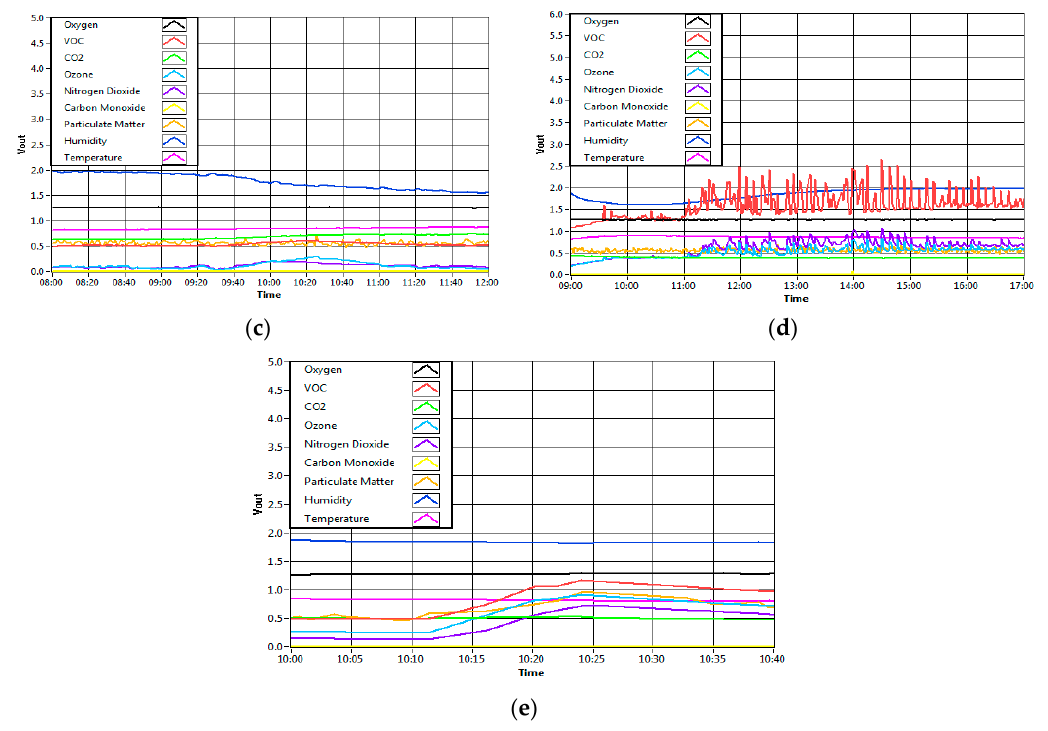
Figure 4. ( a ) Ambient environment; ( b ) Chemical presence; ( c ) Food and beverages; ( d ) Fragrance presence; and ( e ) Combustion activity.